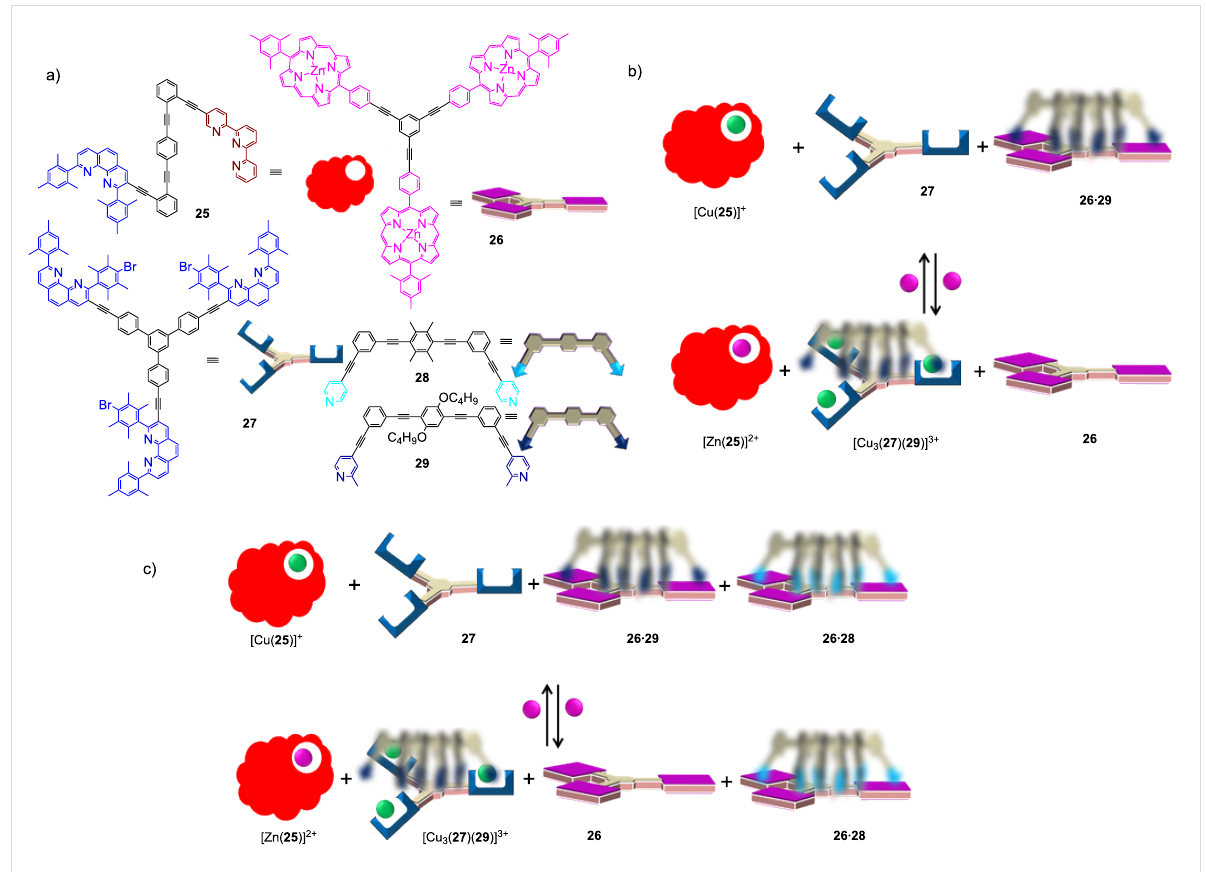
Figure 11: (a) The chemical structures and cartoon representations of the switch 25 , the decks 26 and 27 , and the bipeds 28 and 29 . (b) The double self-sorting led to a reversible interconversion of two different nanosliders triggered by the addition and removal of Zn 2+ . (c) Selective and reversible interconversion of nanosliders initiated by the addition and removal of Zn 2+ . Reproduced with permission from